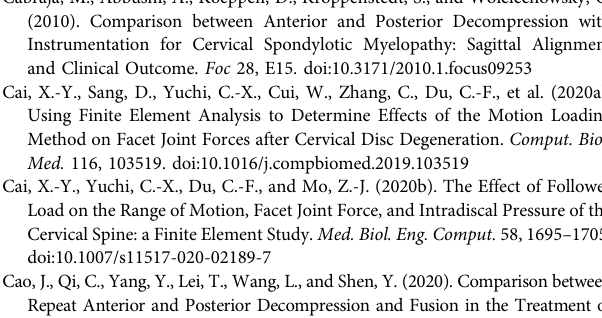
Supplementary Figure S1 | Validation of IDP of the intact cervical